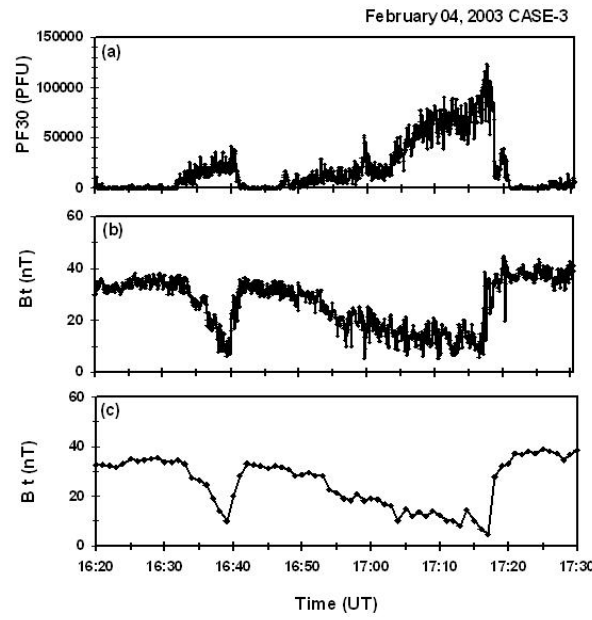
Fig. 15. Plot of the expanded time interval for Burst 1 in Case 3 (4 February 2003). As in Figs. 2 and 5, panels give (a) 4s PF30, and (b, c) 4s and 1min magnetosheath magnetic